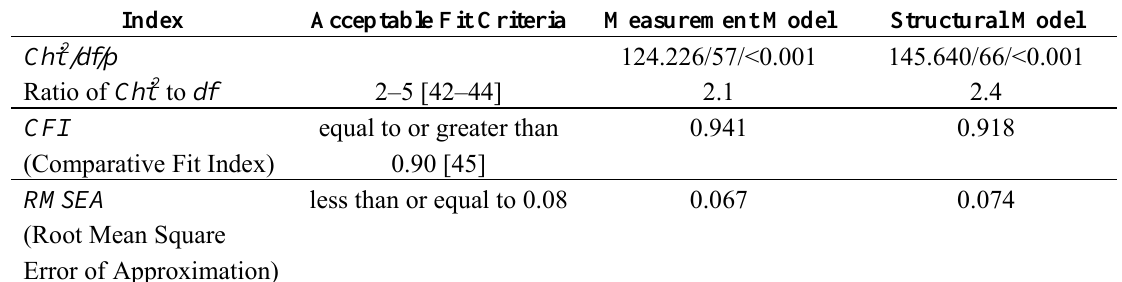
Table 3. Model fit indices of the measurement and tested structural model ( N =